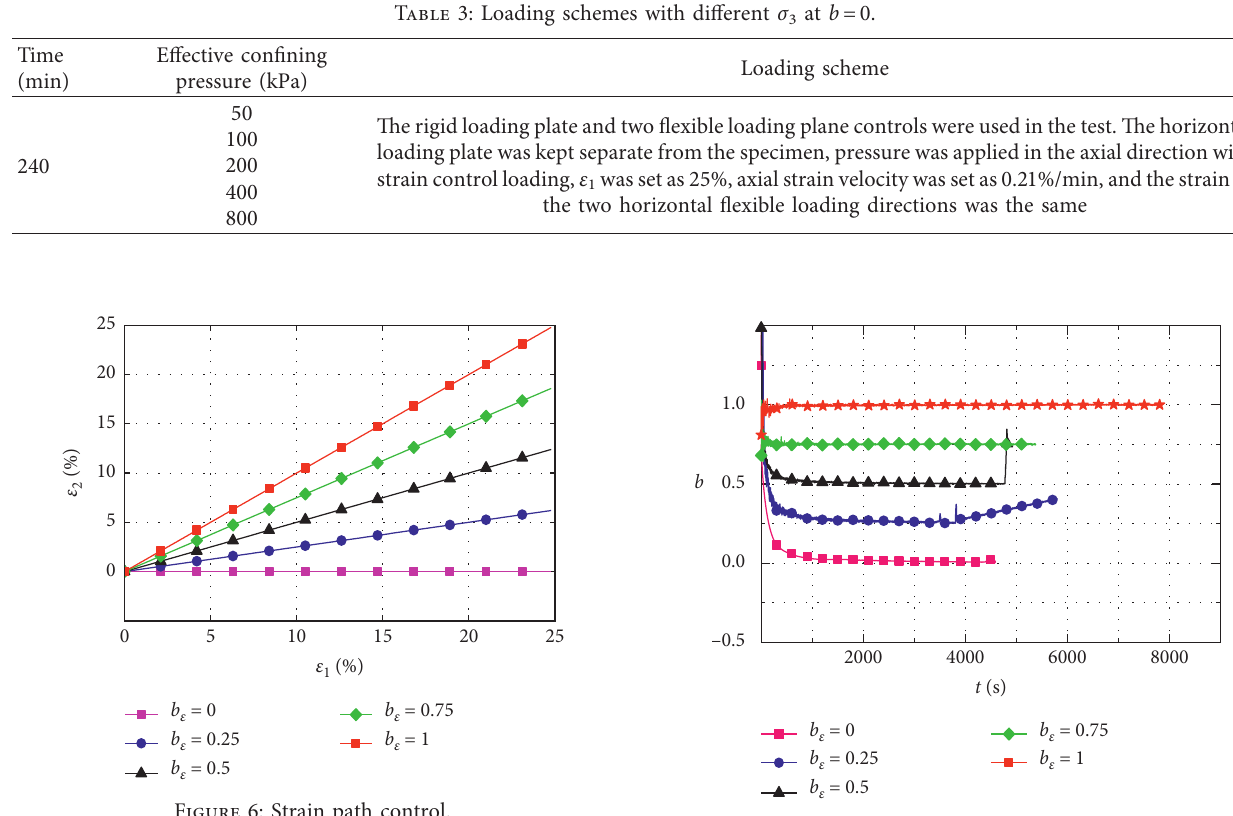
Figure 7: Stress path diagram at σ